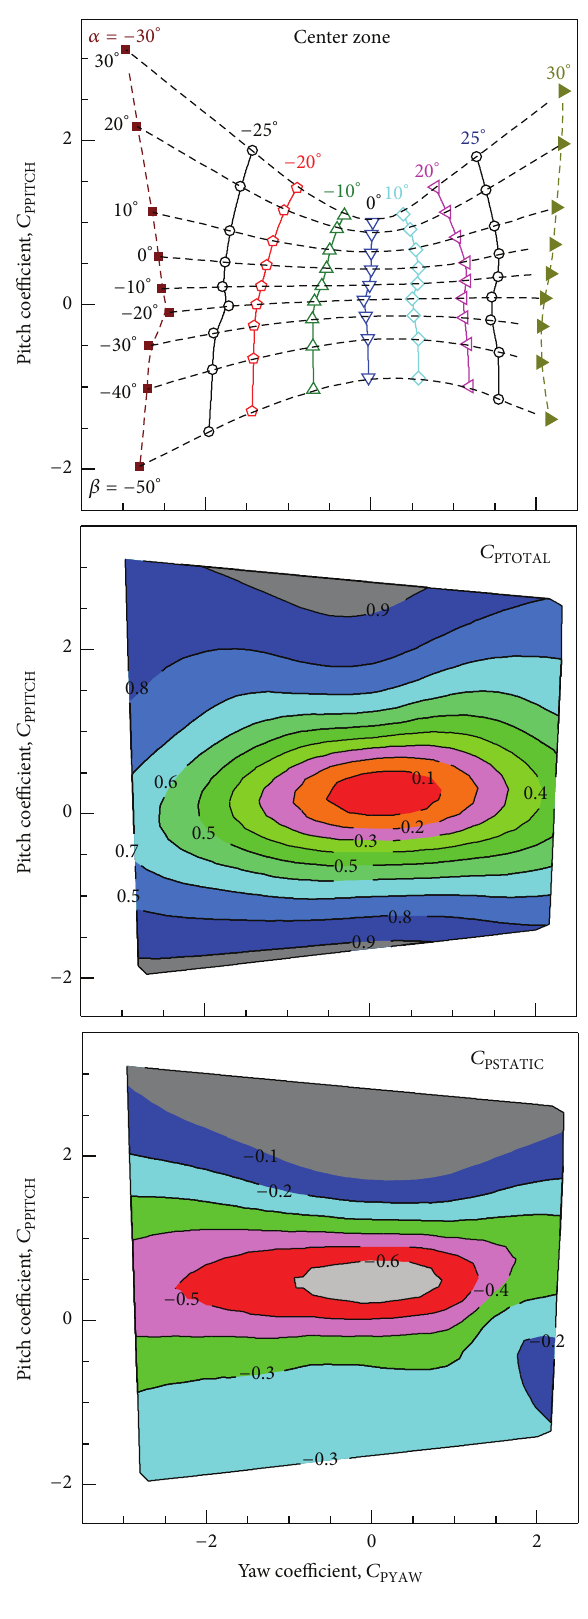
Figure 6: Calibration curves of the four-hole probe for the center